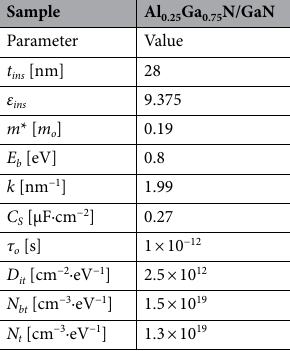
Table 1. Parameters used and extracted values of D it and N bt .